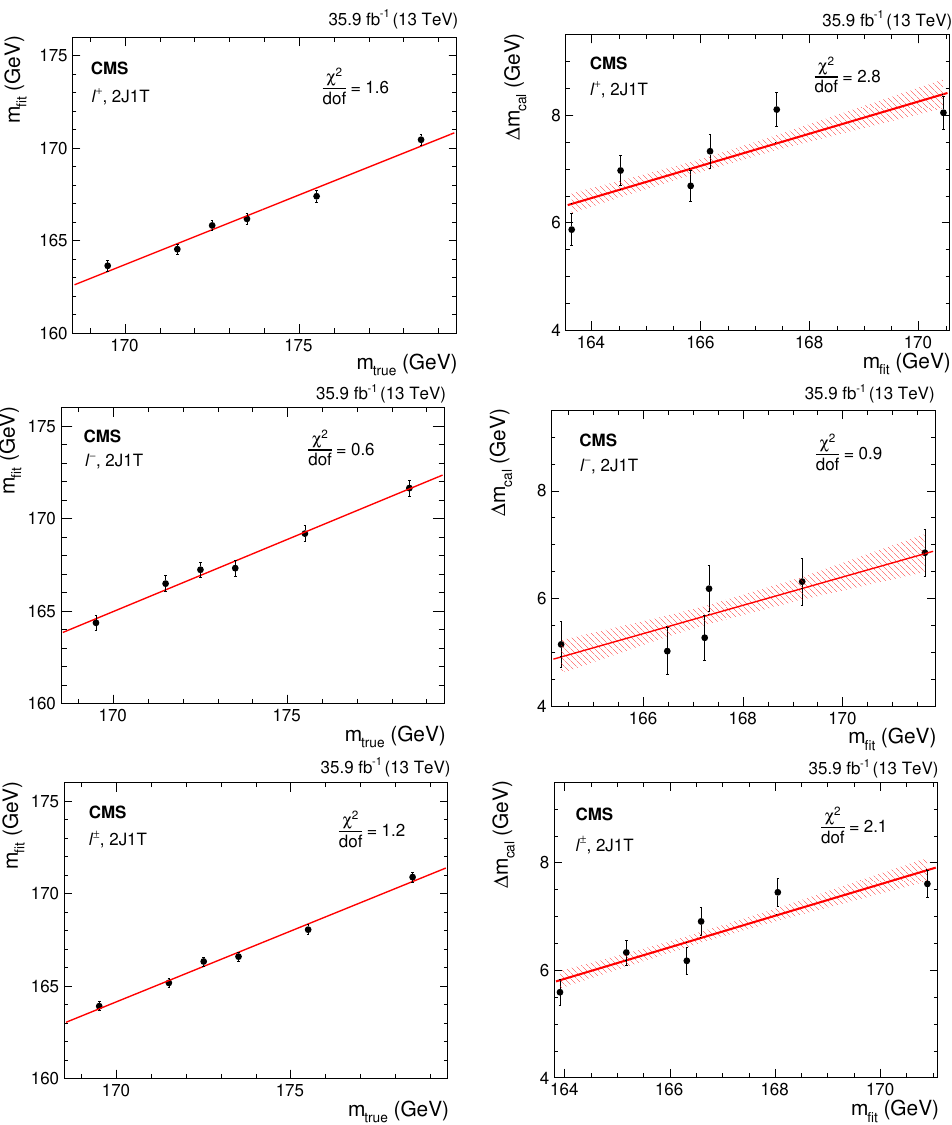
for different values of true mass m (left), and the Figure 8 . Test of the linearity of the m fit true resulting mass calibration ∆ m as a function of m (right) for events in the 2J1T category for the cal fit l + (upper), l − (middle), and l ± (lower) cases. The shaded regions indicate ± 1 standard deviations about the central values defined by the red line. The value of the χ 2 per degrees of freedom (dof) from the linear fit is shown in each